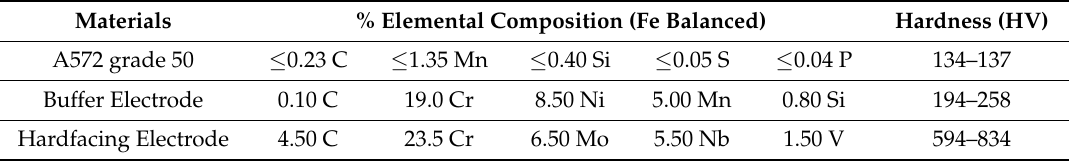
Table 1. Elemental composition and hardness of A572 grade 50 steel and welding electrodes.